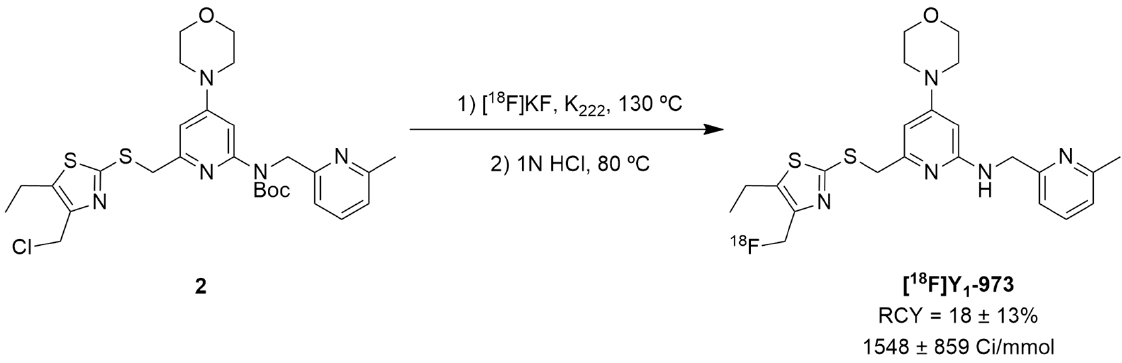
18 F]Y 1 PET tracer [ 1